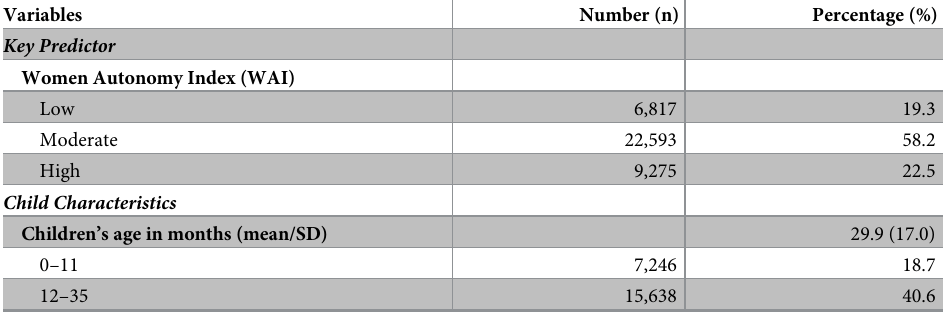
Table 1. Distribution of study participants (n = 38,685), NFHS-4